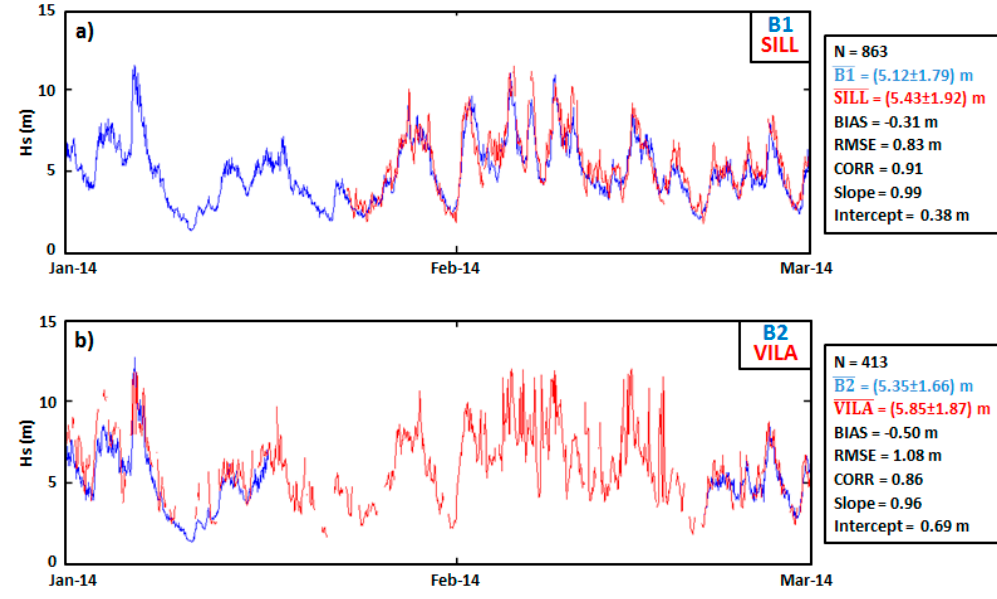
Figure 2. Two-month comparison of high-frequency radar (HFR)-derived significant wave height (red line) against in situ observations (blue line). ( a ) Silleiro site against B1 buoy; ( b ) Vilano site against B2 buoy. Skill metrics are gathered in black boxes on the right side. N represents the number of hourly observations.